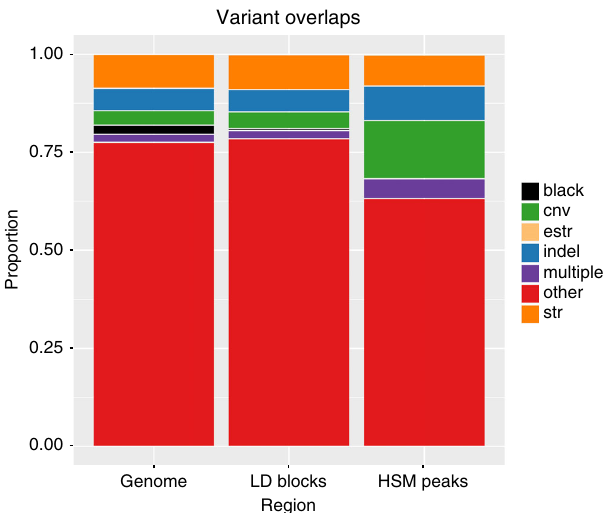
Fig. 2 HSM peak overlap with genetic variants. Overlap of HSM peak signi fi cant windows with genetic variants in the Genome, GWAS LD block regions and the HSM peaks. Black = blacklist regions from ENCODE (removed from subsequent analysis); CNV (Green) = copy number variants from the database of genomic variants from Zarrei et al. 68 ; STR (Orange) = short tandem repeats from Willems et al. 69 ; eSTR (Fawn) = expression- associated short tandem repeats from Gymrek et al. 70 ; Indel (Blue) from TwinsUK data set; multiple variant overlaps (Purple) and other category (Red) will comprise common SNPs which include